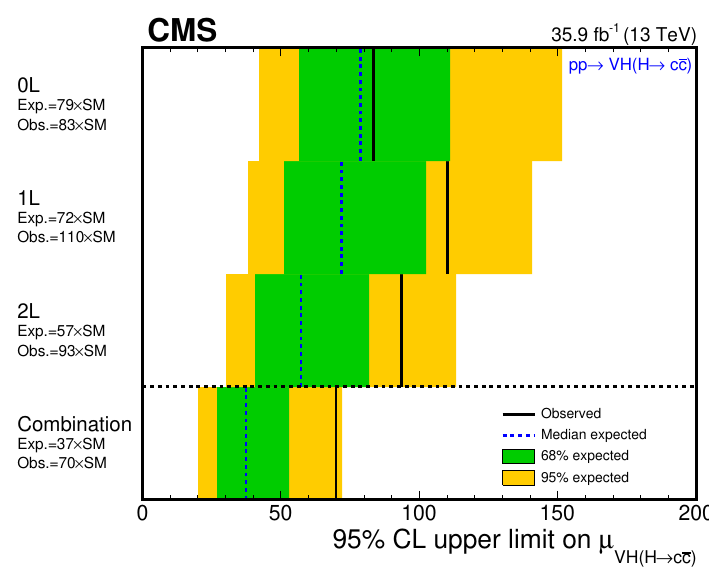
Figure 8 . The 95% CL upper limits on (cid:22) for the VH(H ! cc) process from the combination of the resolved-jet and merged-jet topology analyses in the di(cid:11)erent channels (0L, 1L, and 2L) and combined. The inner (green) and the outer (yellow) bands indicate the regions containing 68% and 95%, respectively, of the distribution of limits expected under the background-only